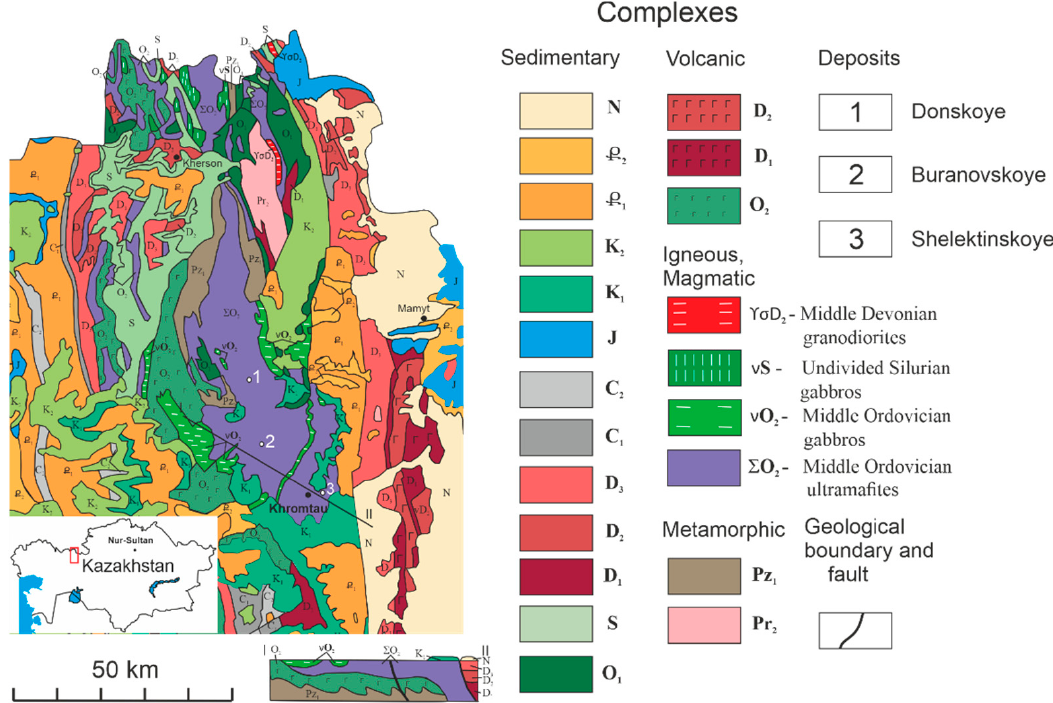
Figure 1. Scheme of the geological structure of the Kempirsay massif of ultramafic rocks [5,6,13].